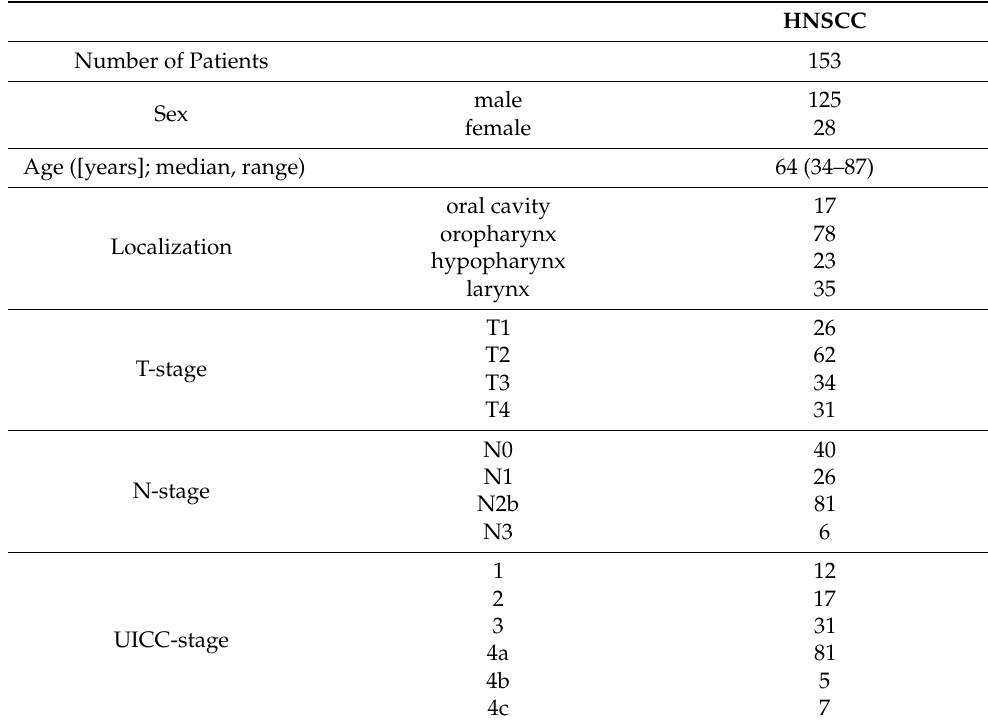
Table 1. Clinical characteristics of included HNSCC